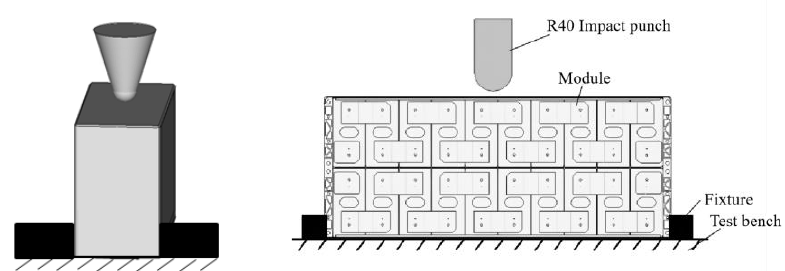
Figure 2. The fixed mode diagram of the battery cell and module.